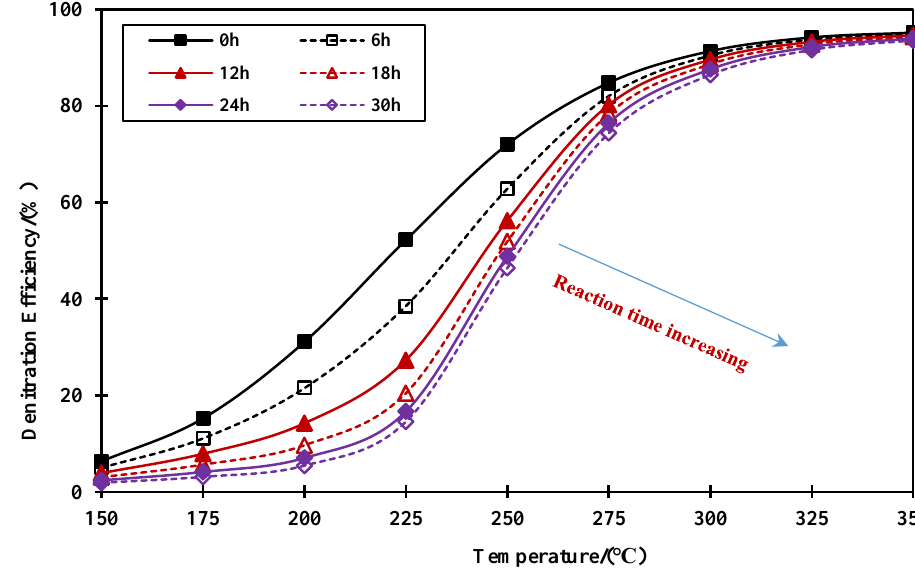
Figure 14. The relationship between the denitration efficiency and the exhaust gas temperature with different reaction times.